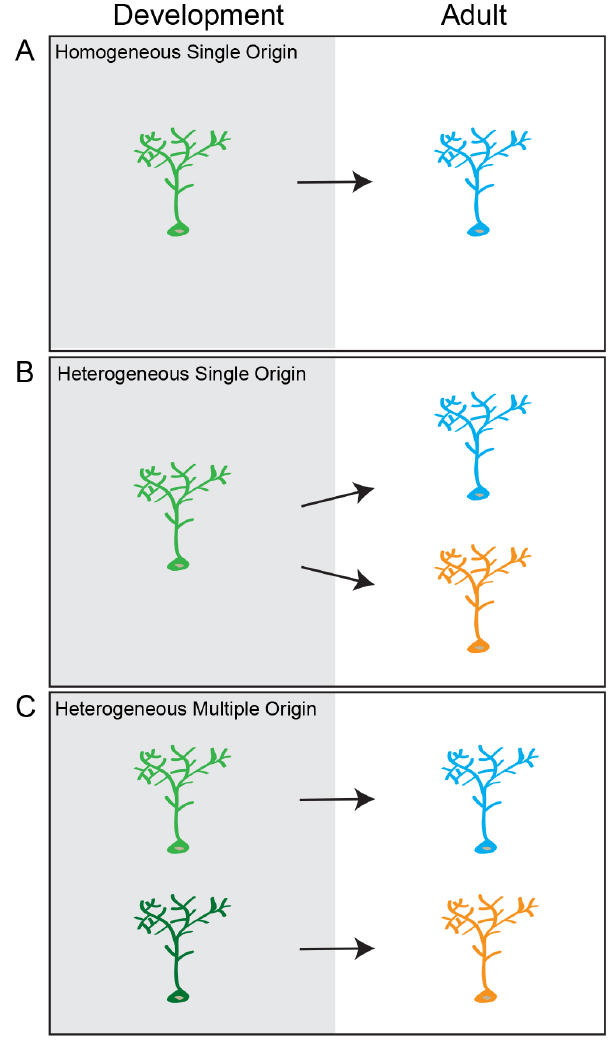
Figure 2. Developmental origin of adult neural stem cell heterogeneity. There are three potential models for the developmental origin of adult neural stem cells. ( A ) Homogeneous single origin: all radial glia-like cells (RGLs) in the adult dentate gyrus (DG) belong to a single population of stem cells that have similar potentials and make similar fate choices. These cells have a common developmental progenitor. ( B ) Heterogeneous single origin: there are multiple populations of RGLs in the adult DG that have distinct potentials and may make different fate choices, but these cells have a common developmental precursor. ( C ) Heterogeneous multiple origin: there are distinct populations of RGLs in the adult DG, and they are generated by different lineage-restricted